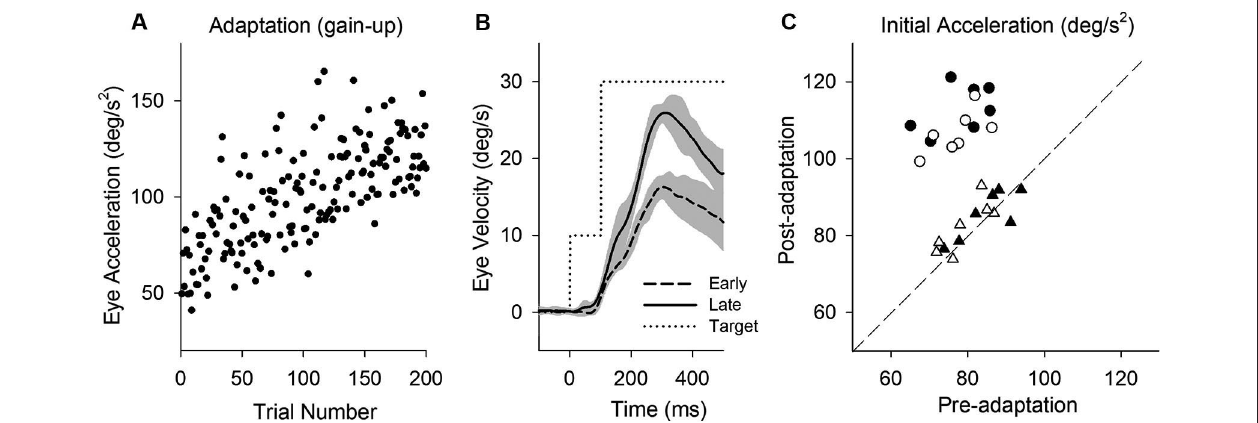
and stepped up to 30 ◦ /s (dotted line). (C) Mean eye acceleration values (first 100 ms) show significant adaptive changes in the direction of a step-up paradigm (circle symbols) but not in the control direction (triangle symbols). Open and filled symbols indicate monkey-P and B,